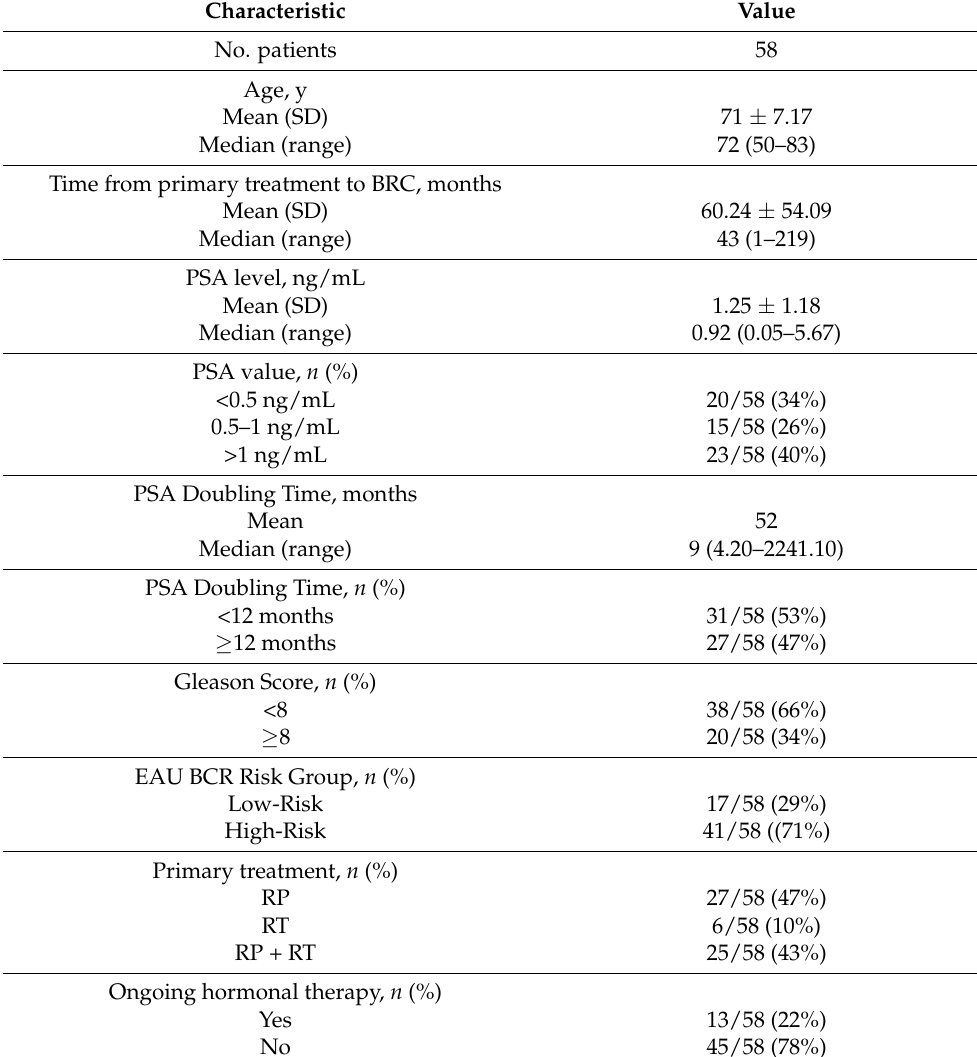
Table 1. Population characteristics ( n =